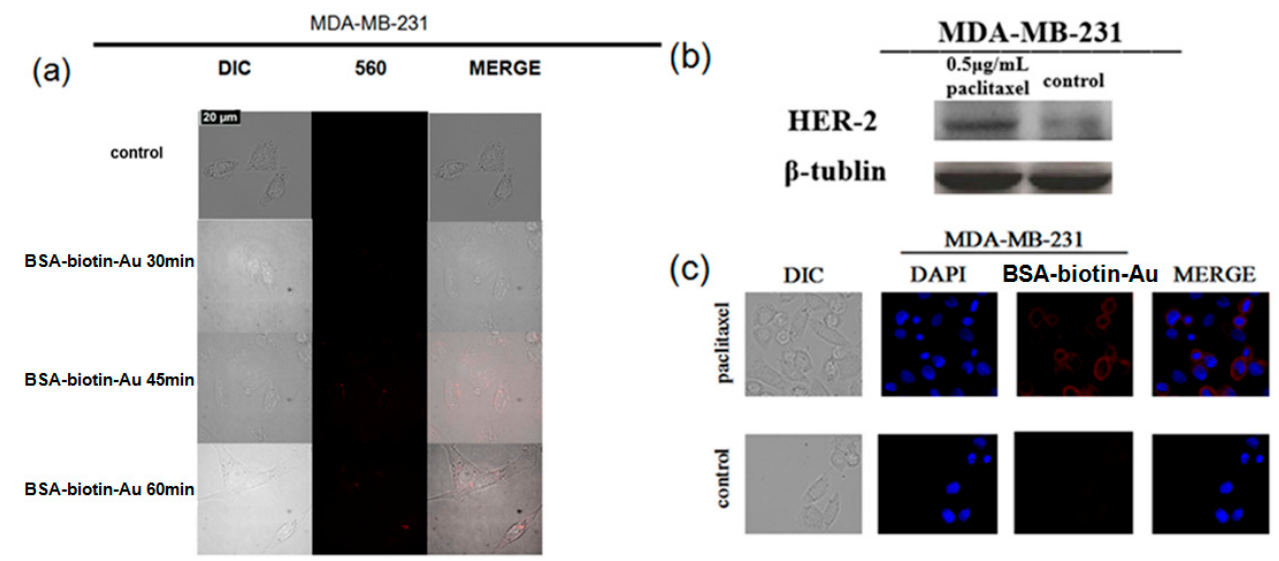
Figure 4. ( a ) Fluorescence imaging of 12 μ M BSA-biotin-Au 25 labeled MDA-MB-231 cells at different time points. ( b ) HER-2 protein expressed in MDA-MB-231 cells before and after paclitaxel stimulation ( c ) Fluorescence imaging of BSA-biotin-Au 25 labeled MDA-MB-231 cells before and after paclitaxel stimulation.